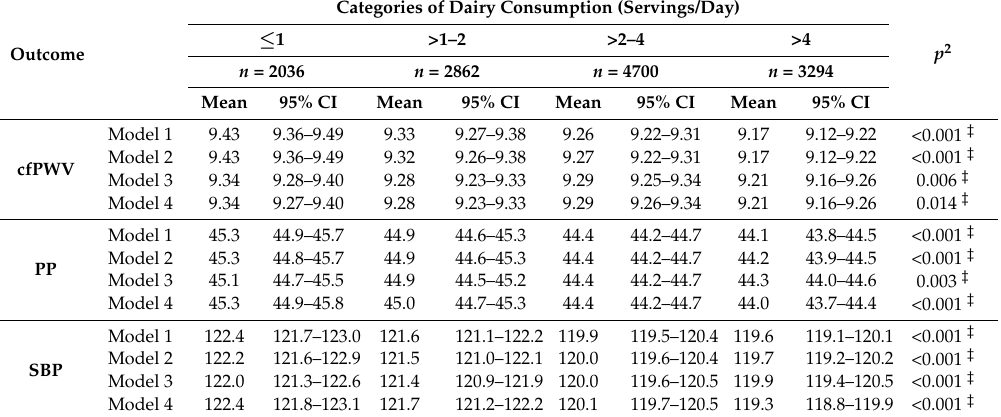
Table 3. Adjusted cfPWV, PP and SBP means 1 according to dairy servings per day among Brazilian adults: ELSA-Brasil,